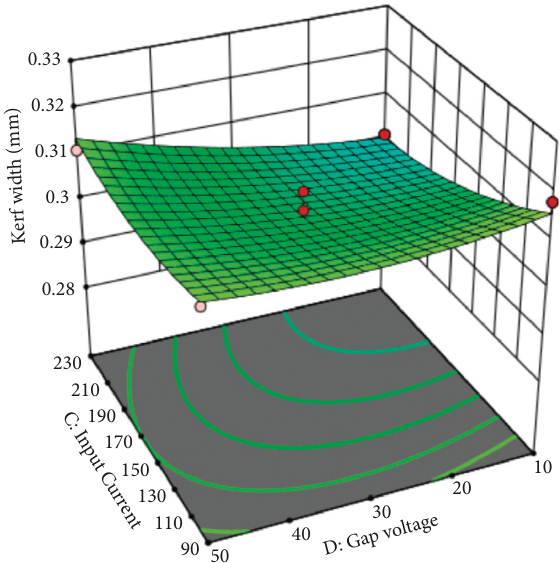
Figure 14: Joint performance on kerf width by T